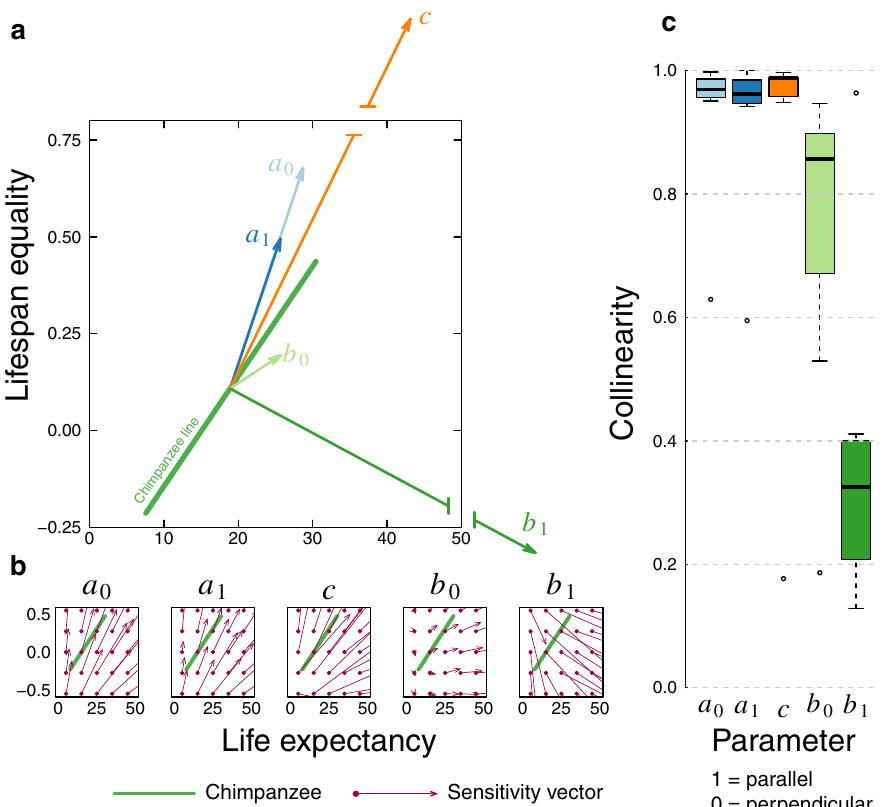
Fig. 2 Sensitivities of life expectancy and lifespan equality to changes in mortality parameters. a Using the female chimpanzee line (bright green) as an example, vectors depict the sensitivity at the mid-point of the genus line. Each vector depicts the direction and magnitude of change in life expectancy and lifespan equality for a unit change in the corresponding Siler mortality parameter. The x - and y -axes show the life expectancy and lifespan equality values of the sensitivity vectors for a 0 (light blue), a 1 (dark blue), and b 0 (light green); vectors for c (orange) and b 1 (dark green) are particularly large, represented by broken lines (Source data are provided as a Source Data File and available in Supplementary Table 2). b Gradient fi eld of sensitivities of life expectancy and lifespan equality to changes in each mortality parameter, showing the direction of change any population would experience for a given change in the parameter, from any starting point in the landscape. The green chimpanzee line is provided for reference. Each sensitivity vector (bright purple) can be interpreted as those in A, but calculated from different points on the landscape). c Boxplots representing the values of the seven collinearity values (one for each genus) for each of the Siler parameters for n = 7 independent genera. Collinearity is calculated between the mid-point of the genus line and the sensitivity vector for each parameter; a value of 1 would imply that the vector is parallel, a value of 0 would imply that it is perpendicular. Note the relatively large collinearity values for a 0 (light blue), a 1 (dark blue), and c (orange), the intermediate value for b 0 (light green) and the relatively small value for b 1 (dark green). The boxplots indicate median (horizontal black line), 25th and 75th percentiles (box), the whiskers are extend to 1.5 the interquartile range, and the open points are extreme values (Source data are provided as a Source Data File and available in Supplementary Table